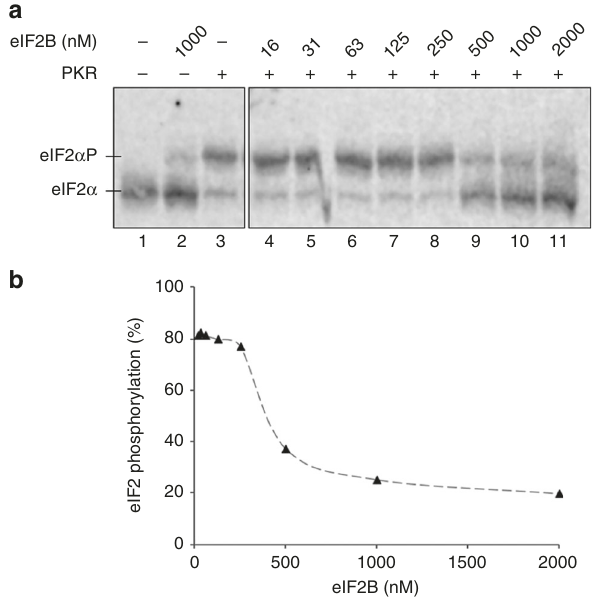
Fig. 4 eIF2B antagonises RNA -activated protein kinase (PKR) activity. a Western blot of eIF2 α phosphorylation (1 µ M eIF2) by PKR (10 nM), when incubated in the presence of increasing concentrations of eIF2B. eIF2 α and eIF2 α P resolved by Phos-tag acrylamide gel electrophoresis. Both panels are from the same blot. Experiment repeated four times with similar